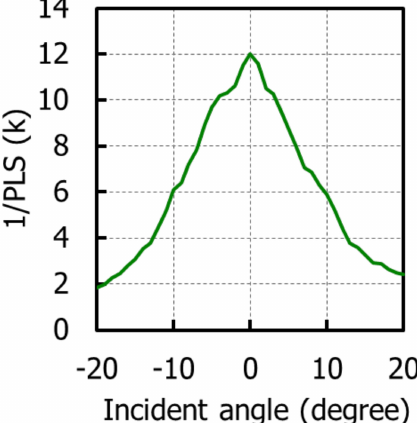
Figure 14. Angularresponseof1 / PLS(parasiticlightsensitivity)withagreenpixelinthehorizontaldirection.